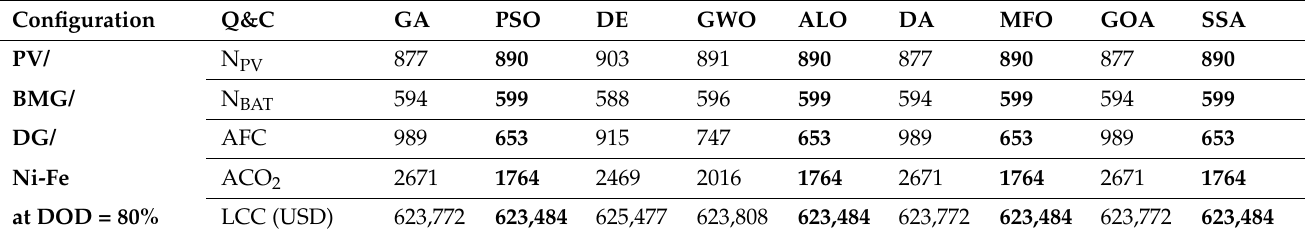
Table 11. Optimization results of the MPRAMC-based IHRES using CC strategy at LPSP value of